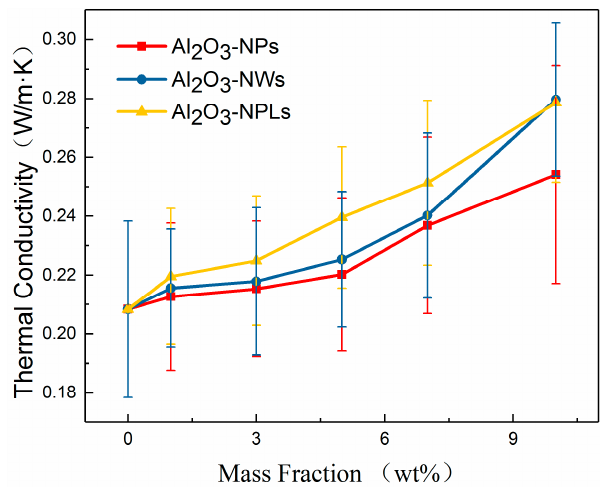
Figure 5. Relationship between the thermal conductivity of composites with the mass fraction of Al 2 O 3 nano-fillers.